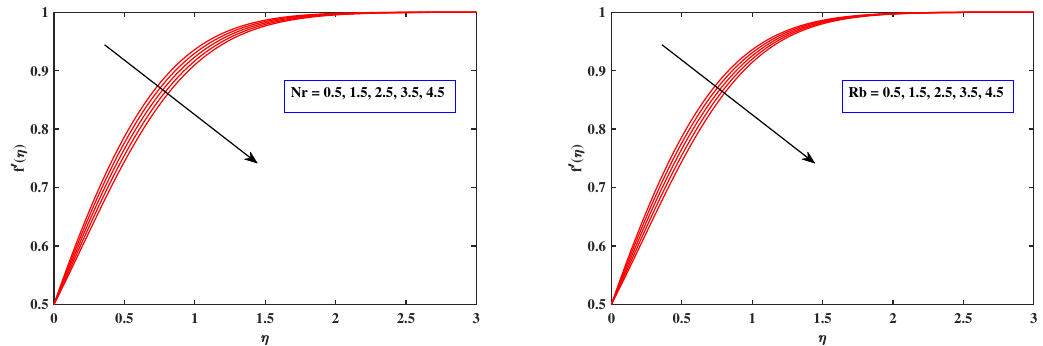
Figure 5. Fluctuation in velocity profile with K p , ω , Nr and Rb .